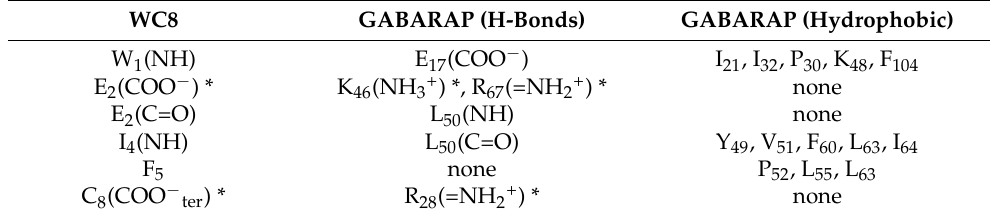
Figure 2. RMSF plots of AnkB-core analogs. Backbone atoms were considered in these calculations. The residues shared by all peptides are highlighted by capital letters. Table 3. List of the interactions established by the GABARAP/WC8 complex during MD simulations.